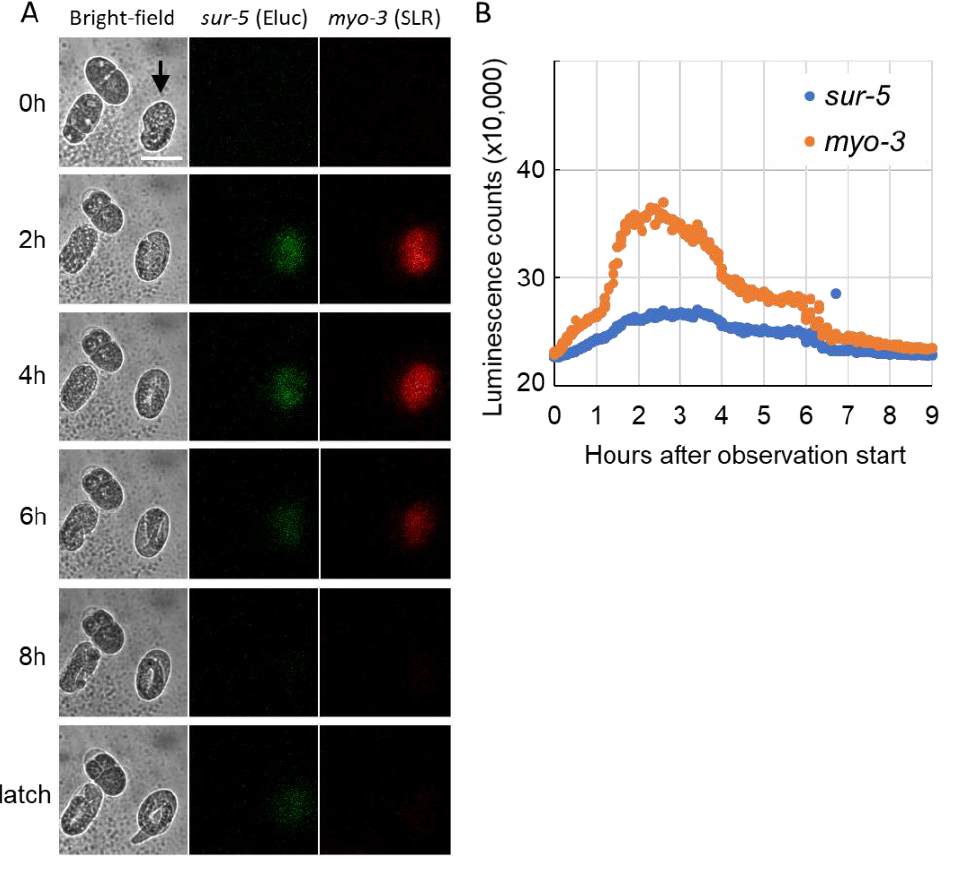
Figure 4. Simultaneous observation of multiple panromoter activities and morphogenesis in transgenic embryos expressing two luciferases. ( A ) Representative bioluminescent images of developing embryos. The bright-field image (left), green-channel image for Eluc ( sur-5 promoter activity, center) and red-channel image for SLR ( myo-3 promoter activity, right) are shown at selected time-points after the start of observation. ( B ) Luminescent count changes in a single embryo marked by an arrowhead in A. Scale bar 50 μm.